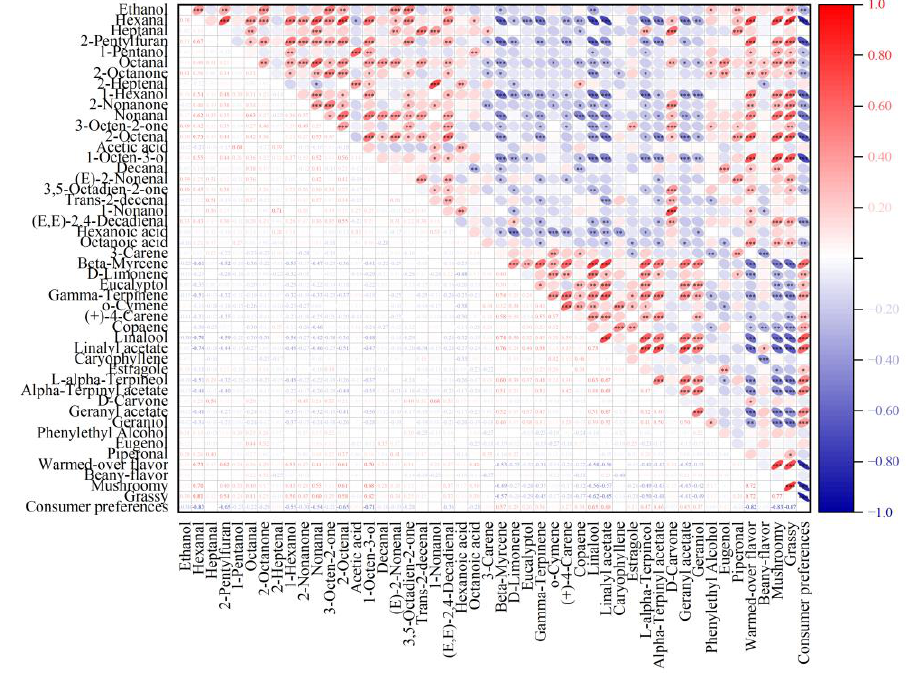
Figure 3. Correlation analysis of commercial plant-based analogs. (* =0.05, ** =0.01 and *** =0.001 level).